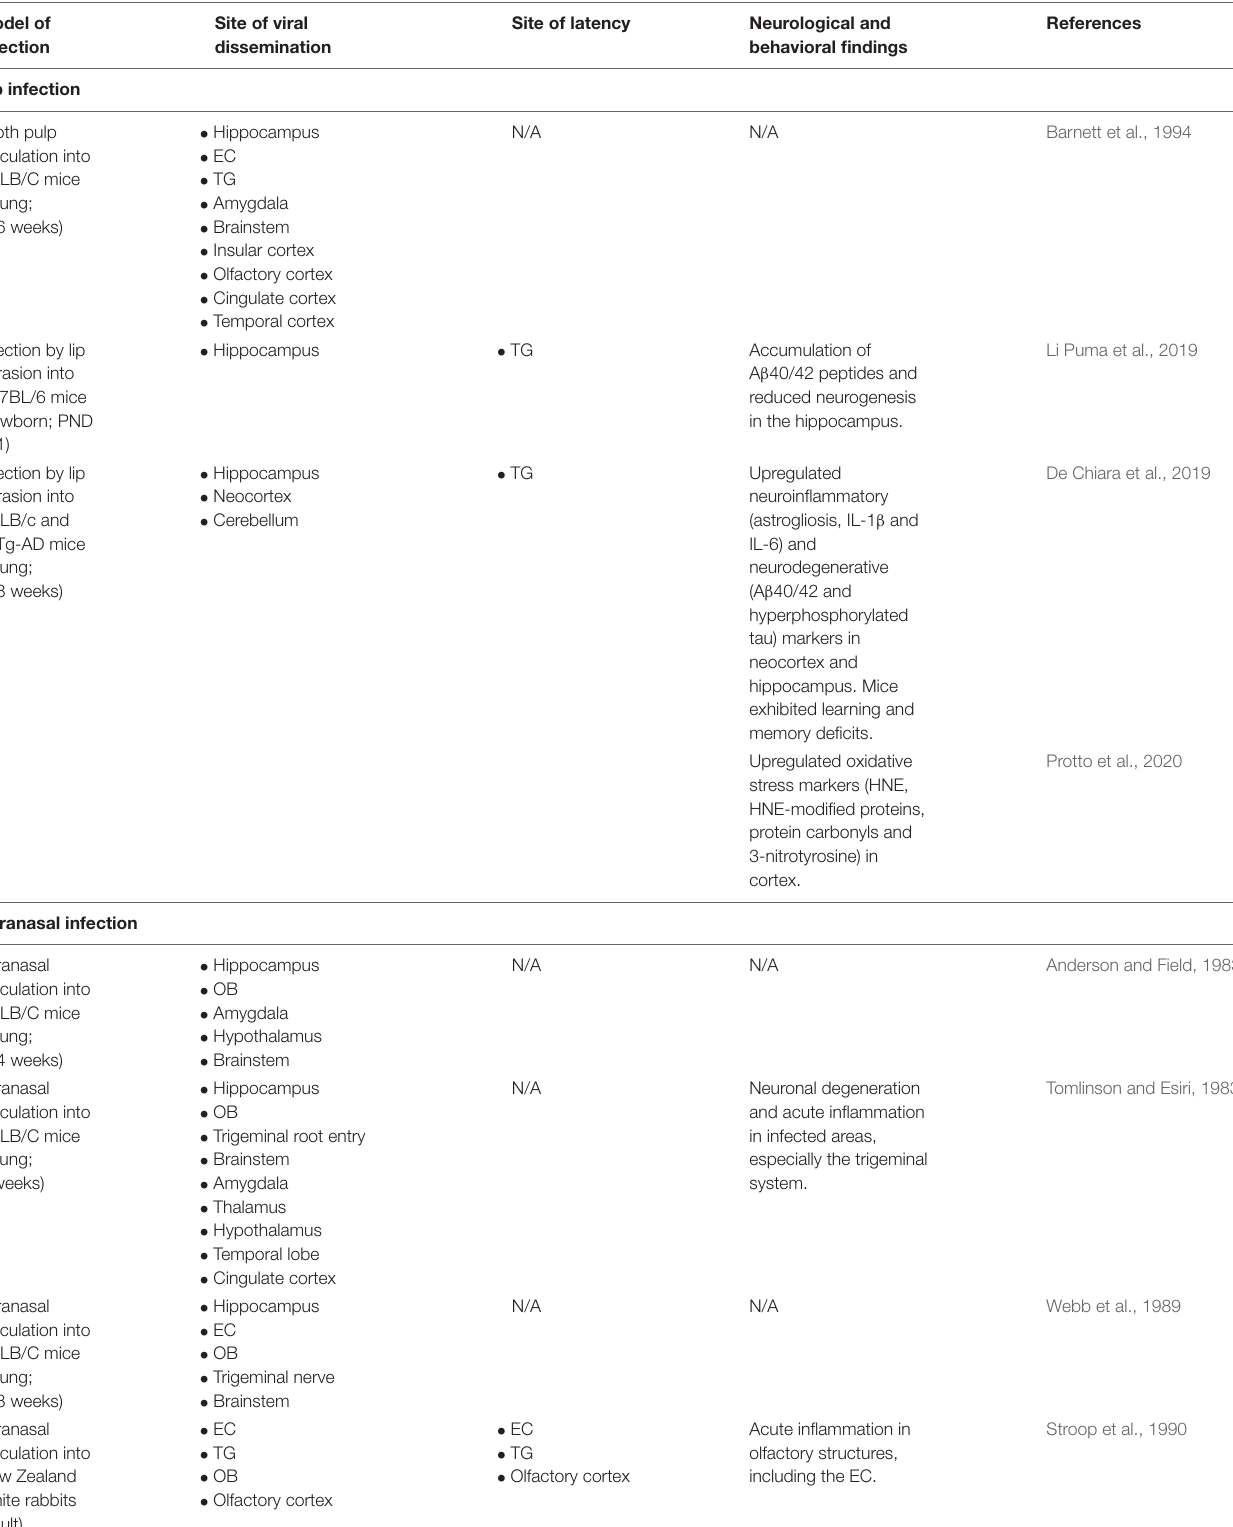
TABLE 1 | Animal infection models assessing the neuronal invasion and spread of HSV-1. Model of